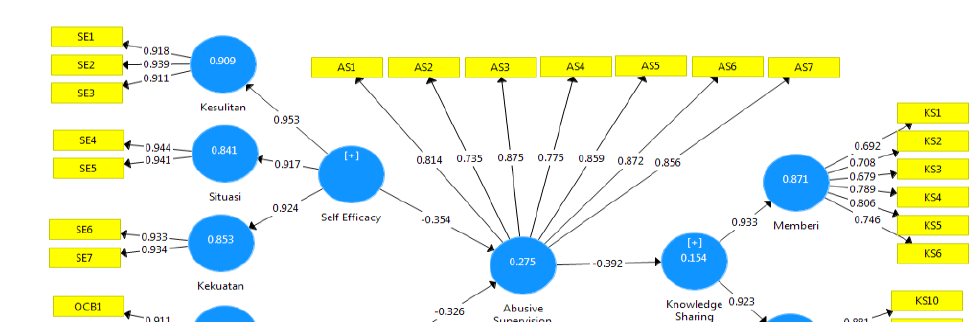
Figure 1: Analysis Results of Preliminary Model Constructive Validity